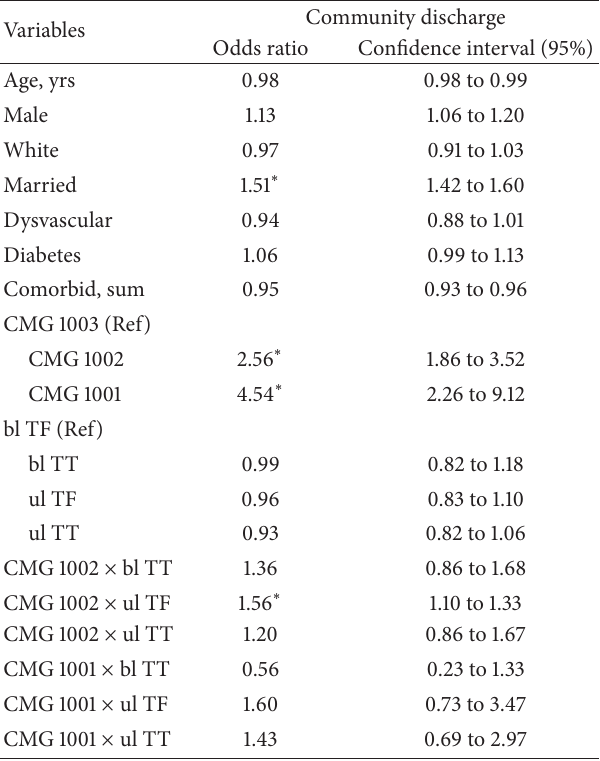
Table 3: Odds ratios from multiple logistic regression model.